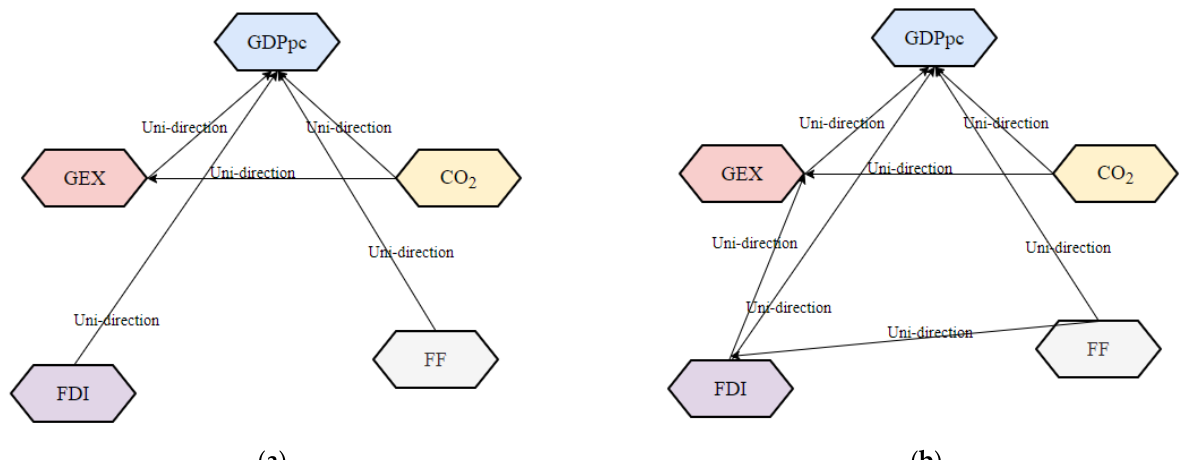
Figure 7. The direction of causality. ( a ) shows unidirectional causalities running from GEX, CO 2 , FDI and FF to GDPpc, and from CO 2 to GEX, in Northern republics; ( b ) shows unidirectional causalities running from GEX, CO 2 , FF and FDI to GDPpc, from GEX to CO 2 , from FF to FDI, and from FDI to GEX in Southern Africa.